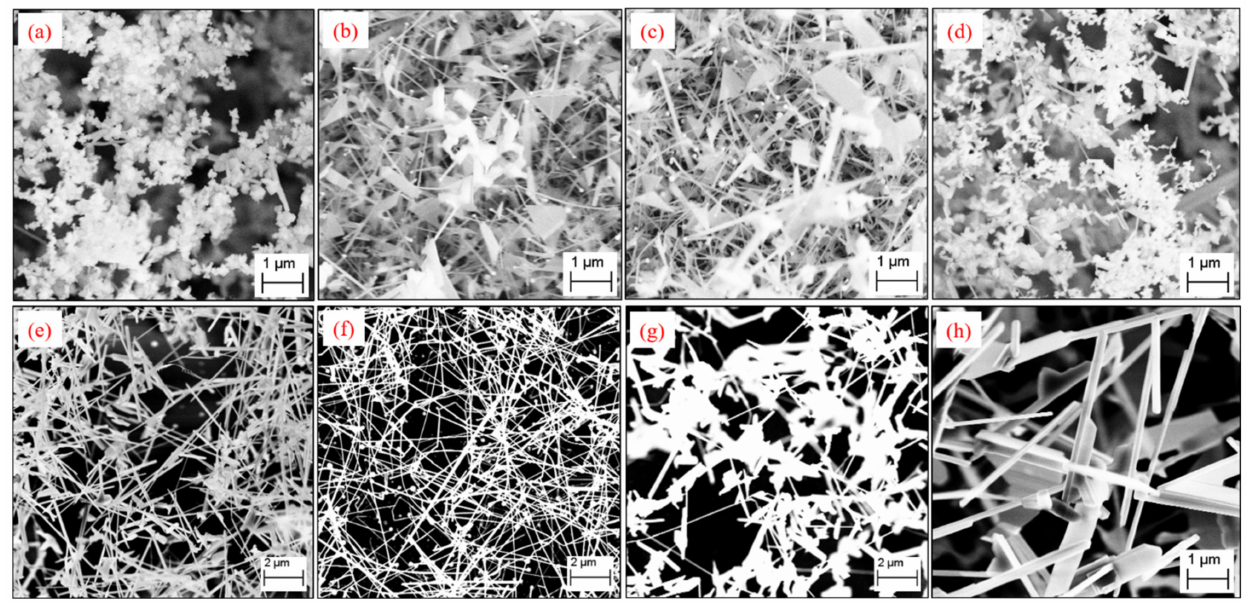
Figure 5. FESEM image of the as-grown β -Ga 2 O 3 nanostructures prepared at 1000 ◦ C for different growth time of ( a ) 30 min, ( b ) 31 min, ( c ) 34 min, ( d ) 35 min, and at 1100 ◦ C for different growth time of ( e ) 30 min, ( f ) 35 min, ( g ) 45 min, and ( h ) 60 min under a constant Ar flow of 50